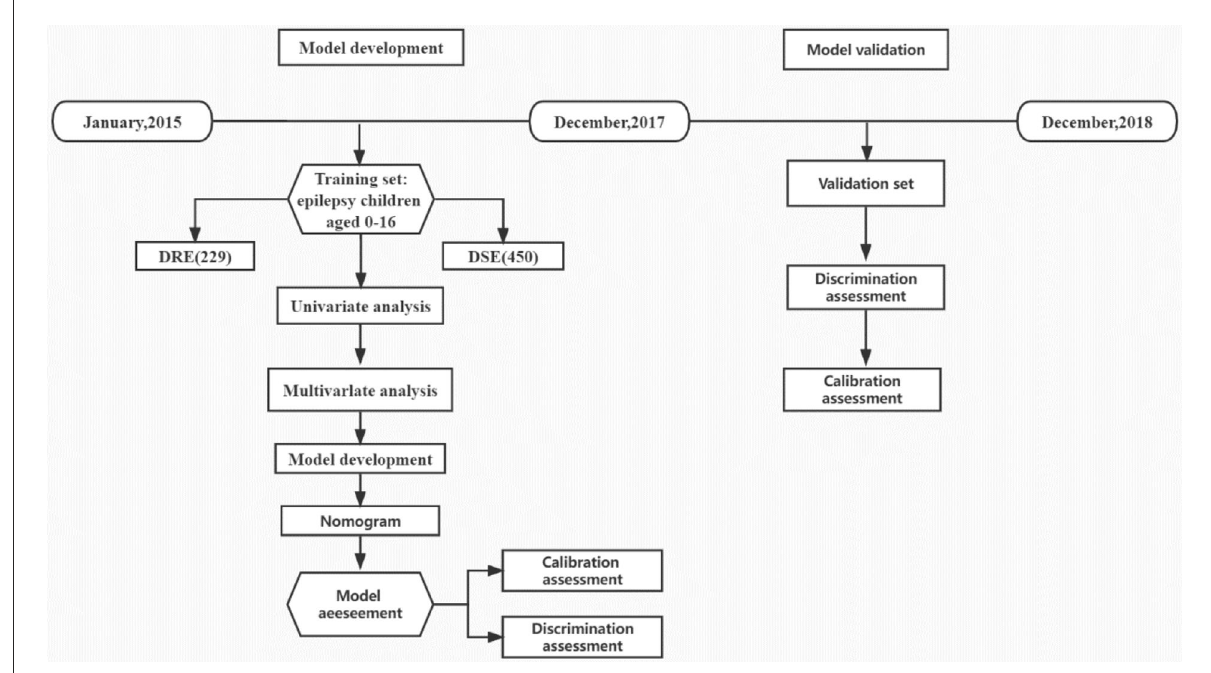
FIGURE1 Technology